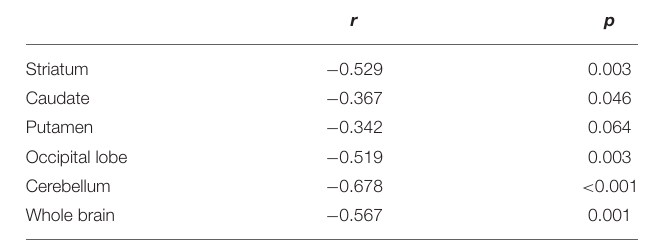
TABLE 4A | Volume (mL) of striatum, caudate, and putamen. TABLE 4B | Correlation between volume and age.